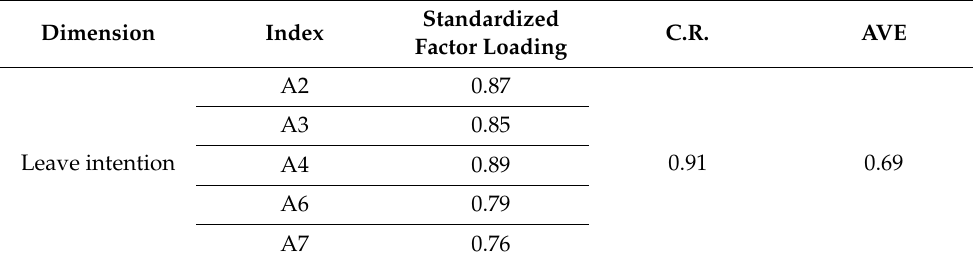
Table 5. Summary of Convergent Validity and Dimension Reliability-Leave